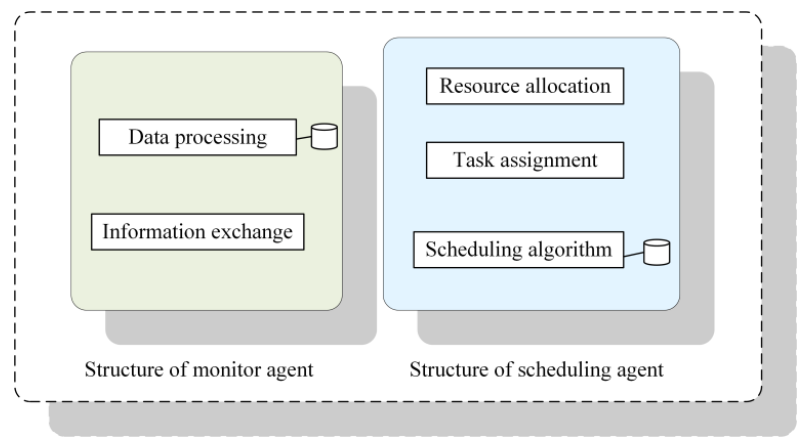
Figure 5. Exemplary structures of reactive agents.